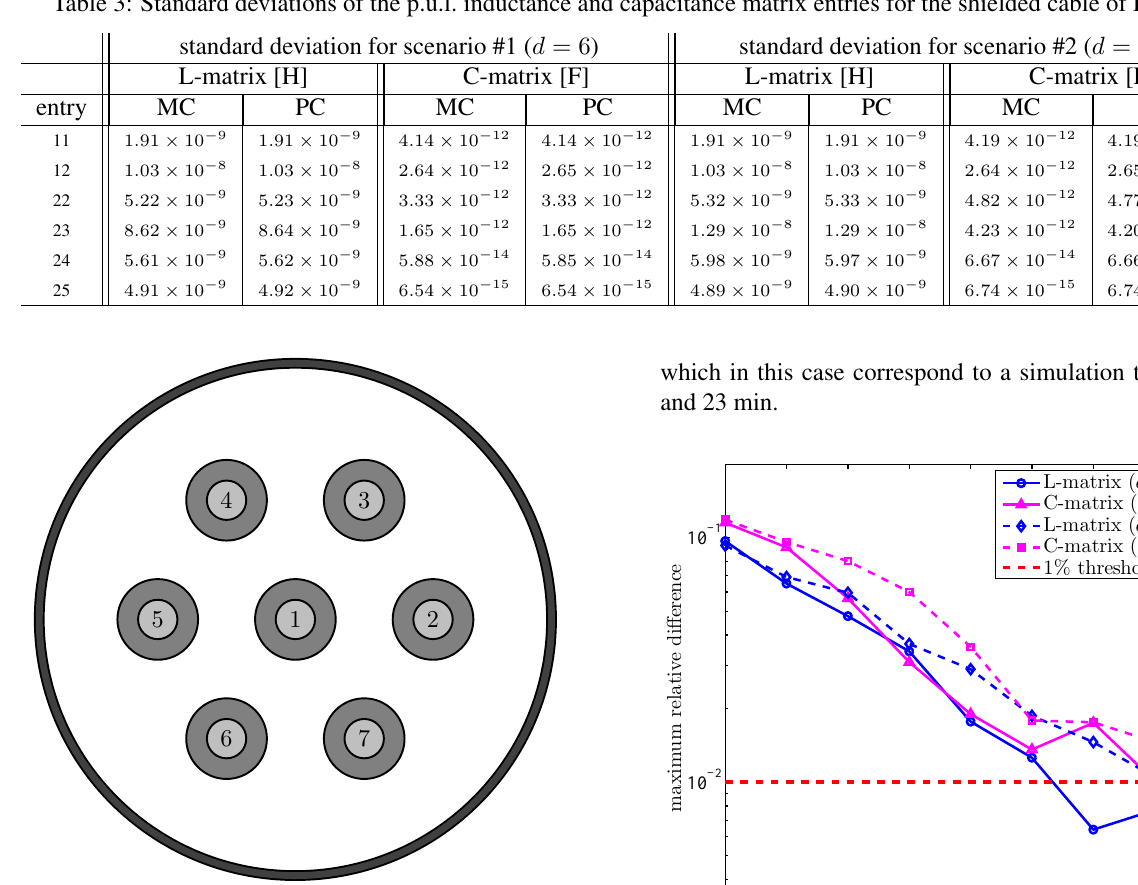
Figure 4: Cross-section of the shielded cable for the second application test case. The radii of the wires, dielectric in- sulations and shield are of 1, 2 and 10 units, respectively.